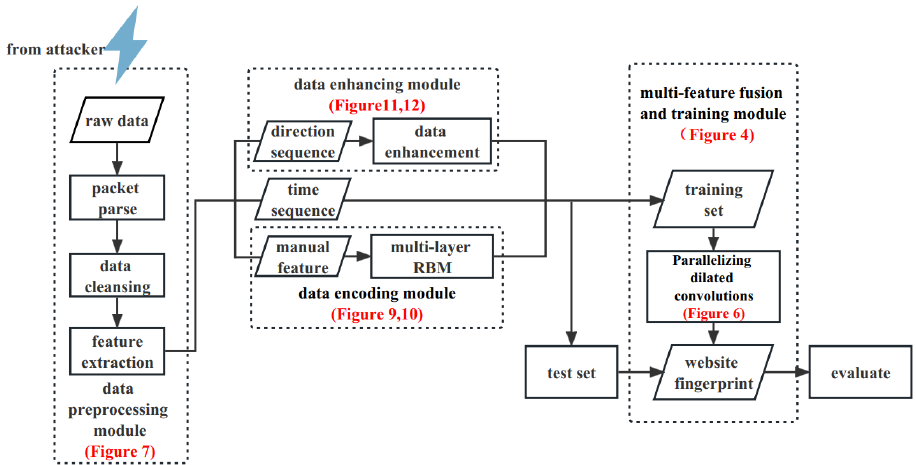
Figure 3. Tor anonymous traffic identification architecture.